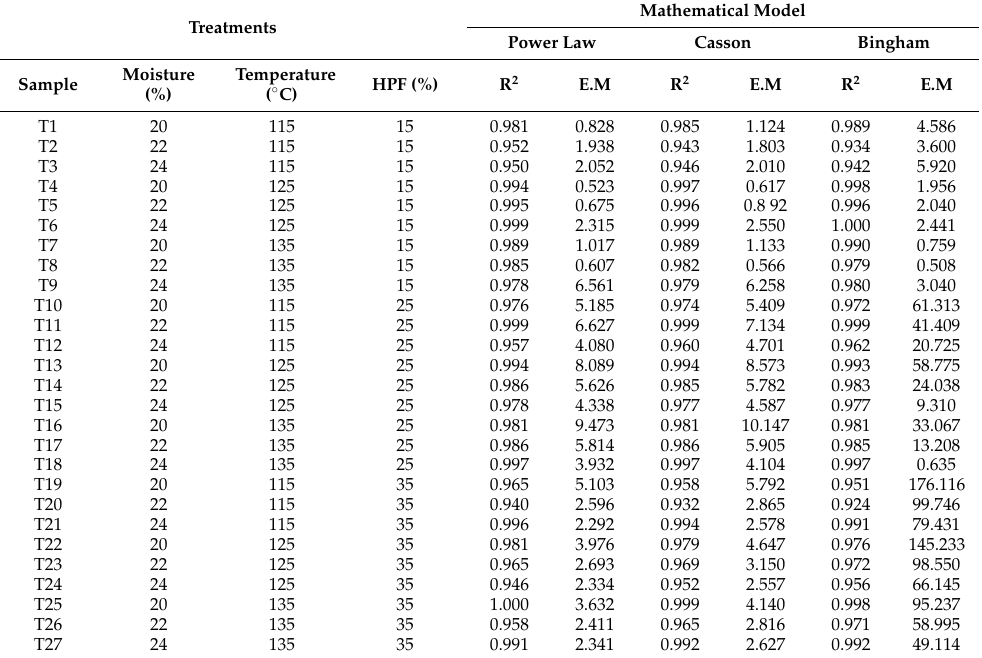
Table 5. Coefficient of determination (R 2) and standard error (E.M) values of the Power Law, Casson, and Bingham